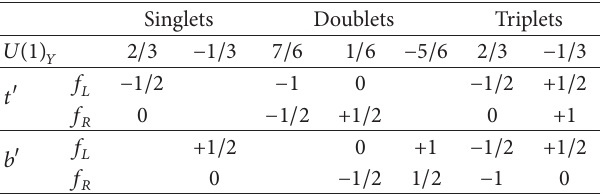
Table 2: Neutral current parameters 𝑓 𝐿 and 𝑓 𝑅 . Singlets Doublets